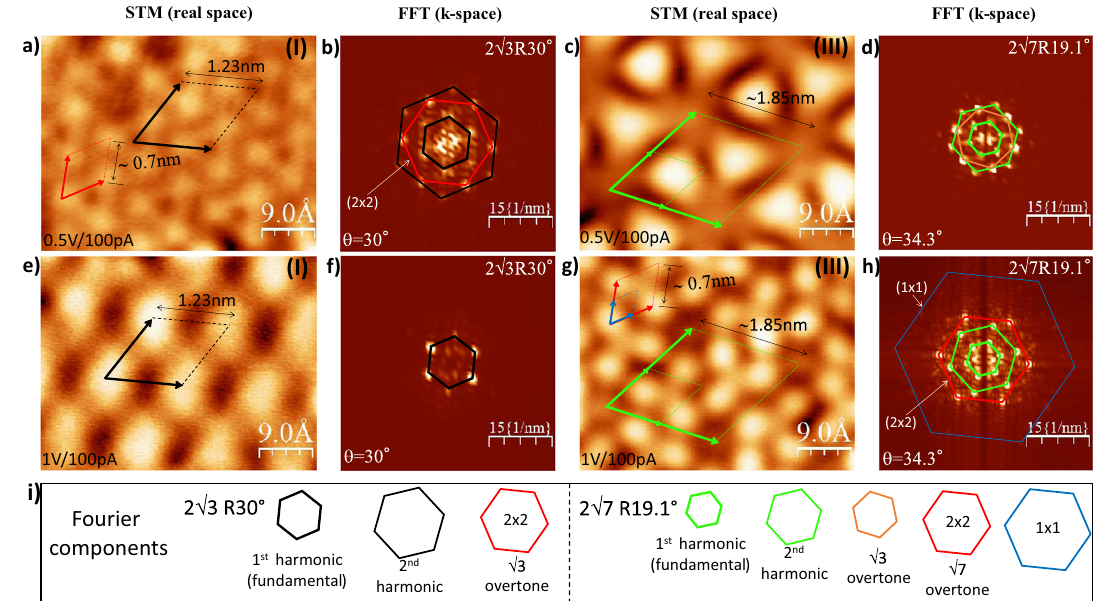
ffiffiffi p 3 R30 ∘ (region (I) ) and 2 ffiffiffi p ffiffiffi p 3 7 R30 ∘ and 2 R19.1 ∘ Moiré patterns. θ marks the twist angle between the graphene and the MoTe 2